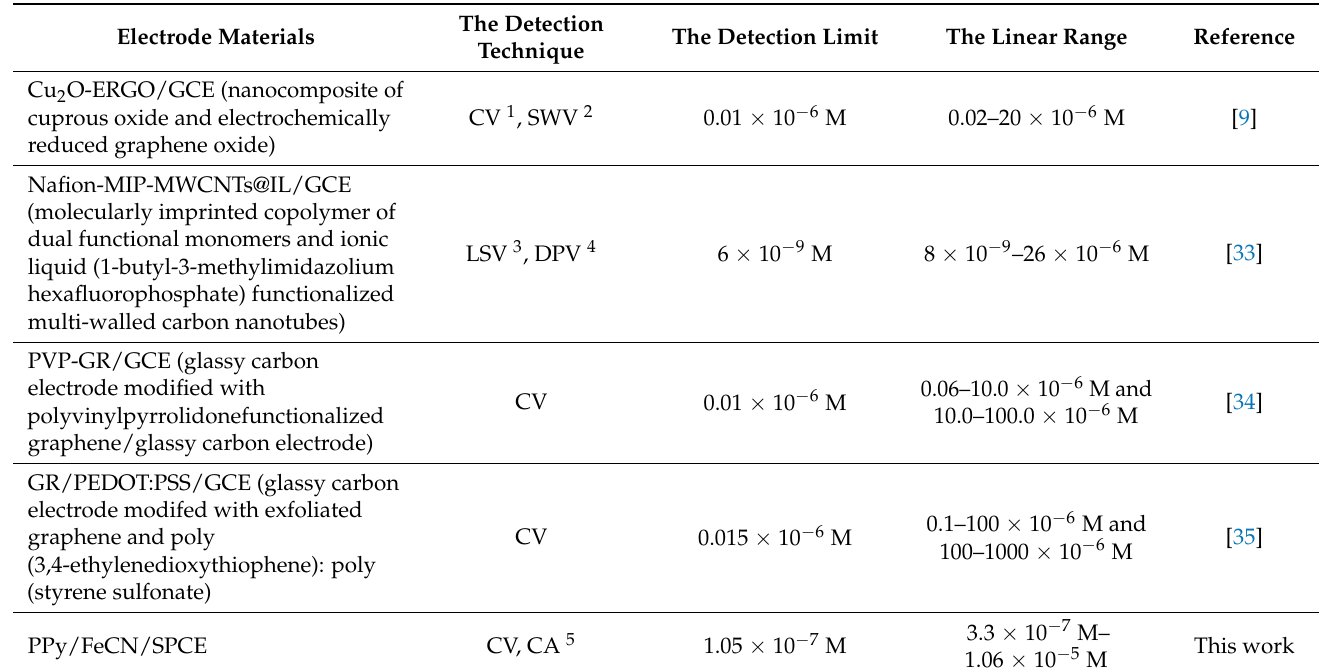
Table 2. The sensitive material, the detection limit and the linear range of the main sensors for the determination of L-TRP through electrochemical